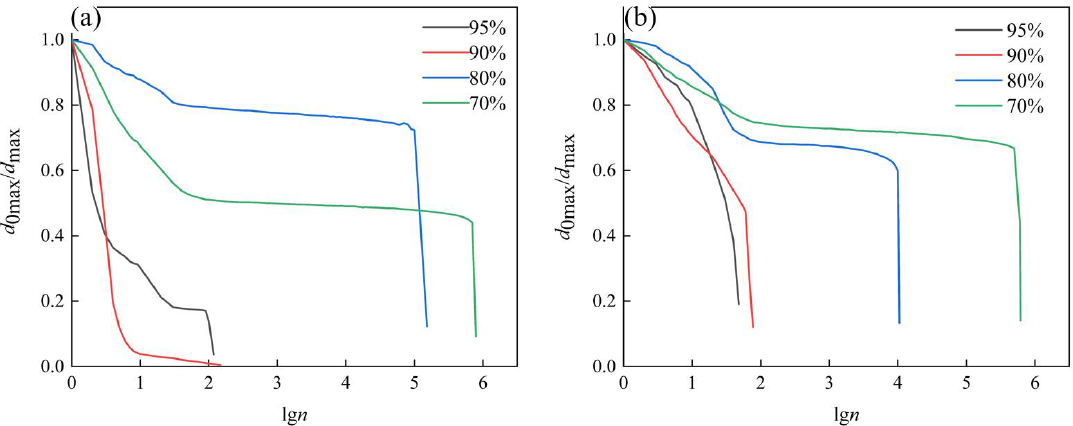
Figure 8. Relative displacement curves at different load levels. ( a ) AFS prepared by the powder metallurgy method, ( b ) AFS prepared by the adhesive method.